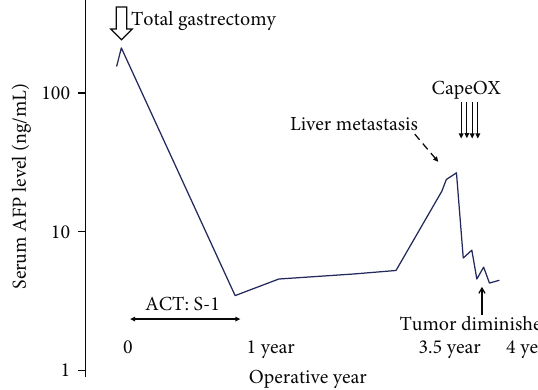
Figure 2: Chronological trend of serum alpha-fetoprotein levels serum alpha-fetoprotein (AFP) levelswas elevatedand abruptlydecreasedafter curative gastrectomy. Metachronous liver metastasis and increases in serum AFP levels were detected 3.5 years after the initial gastrectomy. After four cycles of CapeOX combination chemotherapy, the solitary liver lesion was diminished and serum AFP levels decreased to within normal limits. Abbreviations: ACT: adjuvant chemotherapy; AFP: alpha-fetoprotein; CapeOX: